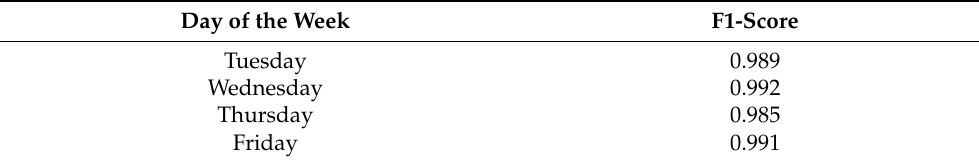
Table 9. Other results based on the CIC-IDS2017 dataset [7].